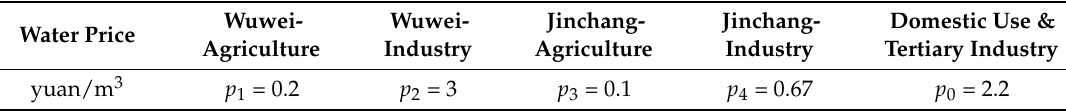
Table 9. Actual water price for base year 2010.